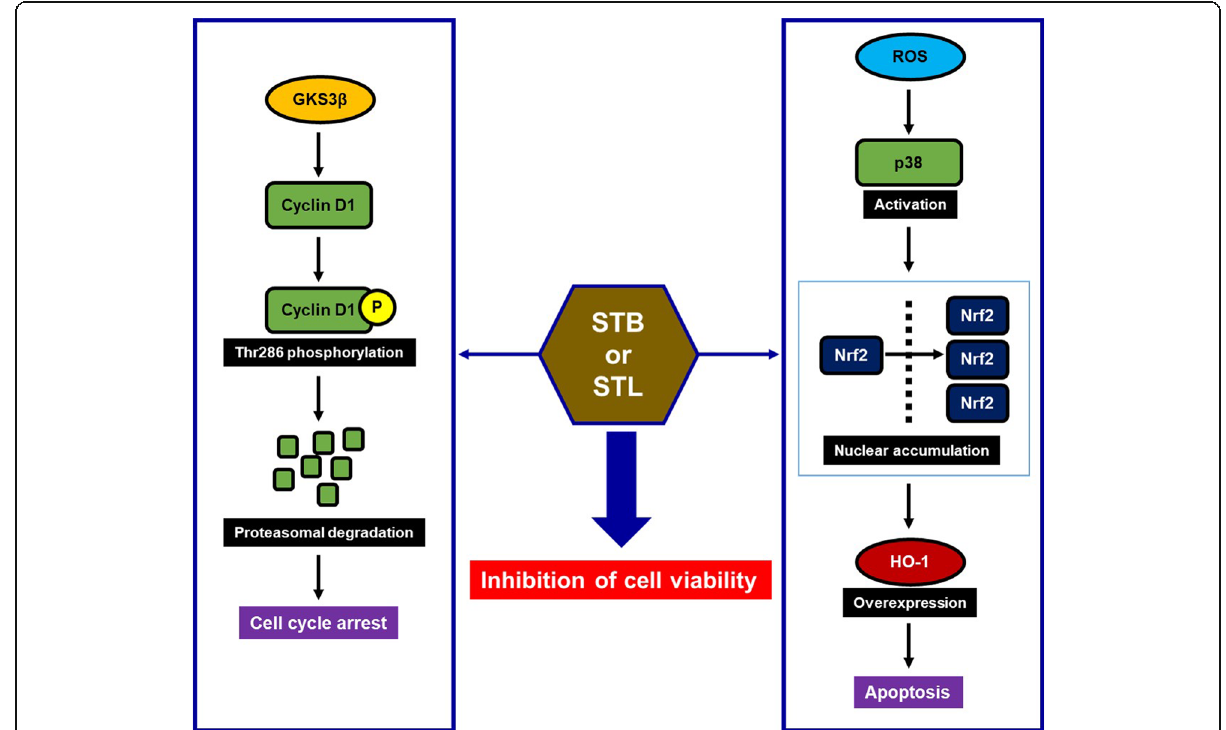
Fig. 7 The proposed cascade of events for STL and STB-induced reduction of cell viability in human colorectal cancer